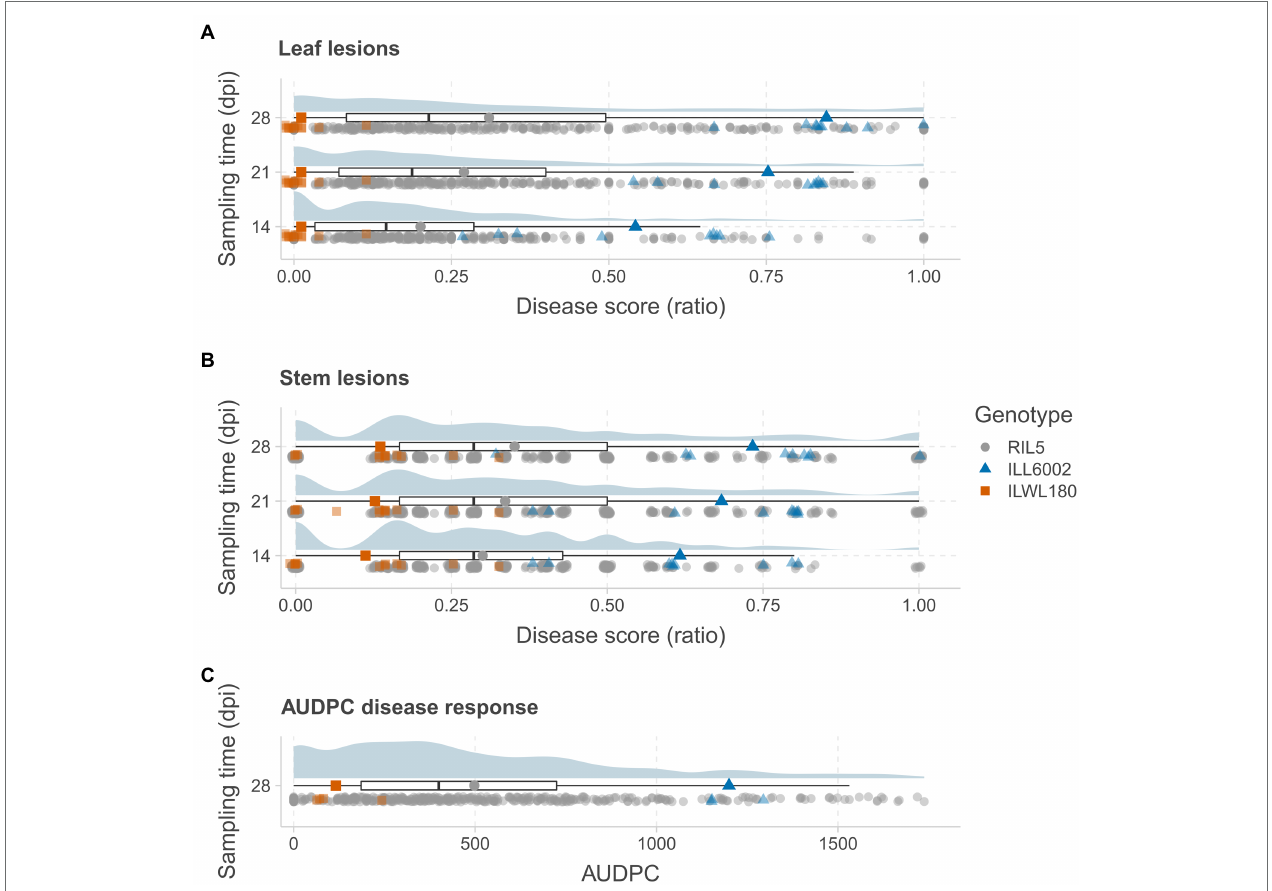
FIGURE 1 | Distribution of AB disease symptoms in a RIL population derived from the cross ILWL 180 × ILL 6002. The distributions of leaf lesion scores (A) and stem lesion scores (B) are presented as ratios at 14, 21 and 28 days post-inoculation (dpi) and AUDPC (C) at 28 dpi. The distributions are presented as raincloud plots, with the median and quantiles shown below as box plots. Each sampling data point is plotted below the box plots, with marker colors and shapes representing genotypes as per the legend (RIL – gray circles; ILL6002 – blue triangles; and ILWL 180 – orange squares). The average scores of the parents and the RIL population are presented as larger markers on the box plots.